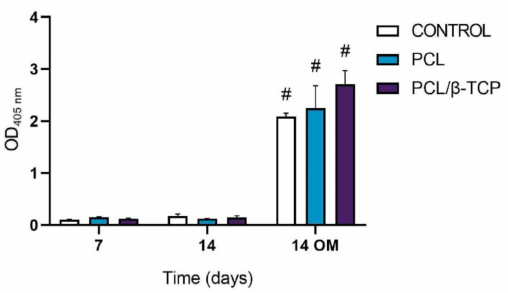
Figure 7. Alkaline phosphatase activity of ah -BM-MSCs seeded on PCL and PCL/ β -TCP scaffolds after 7 and 14 days of culture. Results are shown as a function of optical density (OD) units. No significant differences were found at the same time periods between the groups. Bars represent standard deviations of the mean. # Significant differences between the marked group at different time periods ( p >